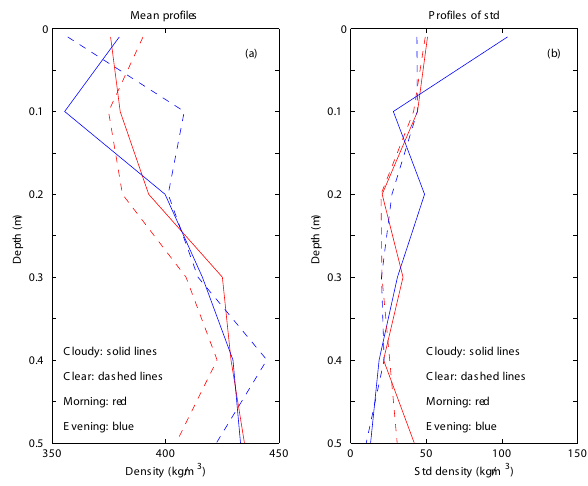
Fig. 7. Mean profiles of (a) snow density and (b) day-to-day standard deviation of snow density near Basen nunatak, averaged over the two summers but calculated separately for cloudy morn- ings (10 days), clear mornings (12 days), cloudy evenings (6 days), and clear evenings (9